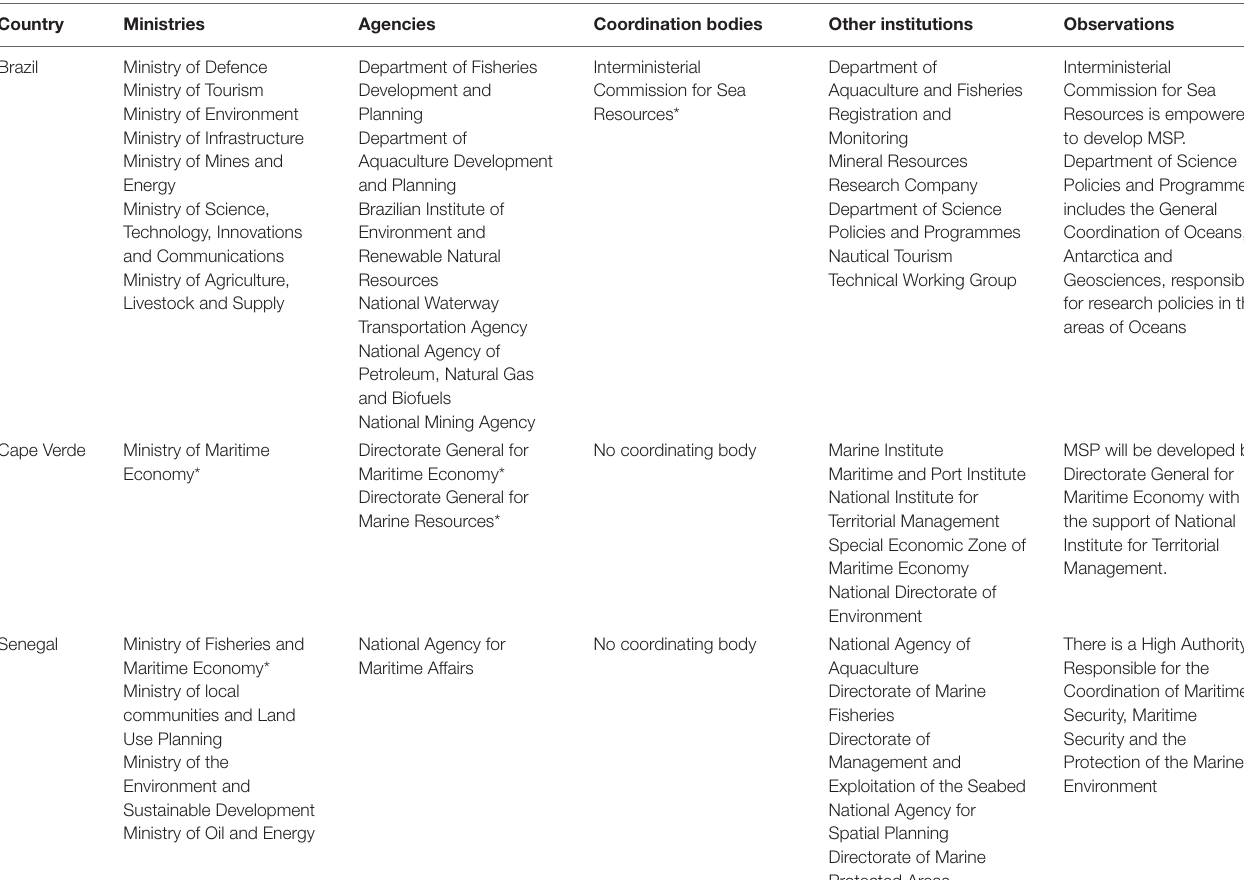
TABLE 3 | Institutional framework for maritime space governance in Tropical Atlantic case studies.